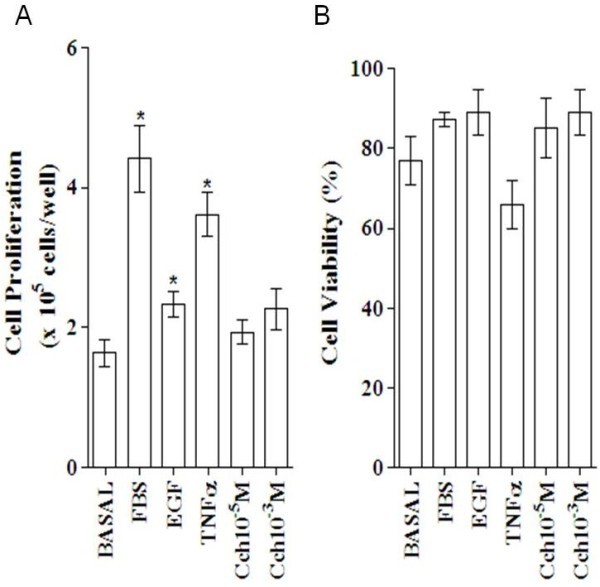
Rat ASMC proliferation (A) and viability (B) in presence of mitogens and Cch. ASMC (2 × 105 cells/well) were cultured in 6 wells plates at 37°C/5%CO2 for 48 hrs in presence of DMEM/F-12 medium (basal), 10% FBS, EGF 10 ng/mL, TNF-α 10 ng/mL and Cch 10-5,-3 M. Cell proliferation and viability were determined using Trypan blue dye exclusion method. Data is the mean ± ES of n = 5 experiments for triplicate. The proliferation responses of each mitogen concentration vs. basal was significant (*) p < 0.05.